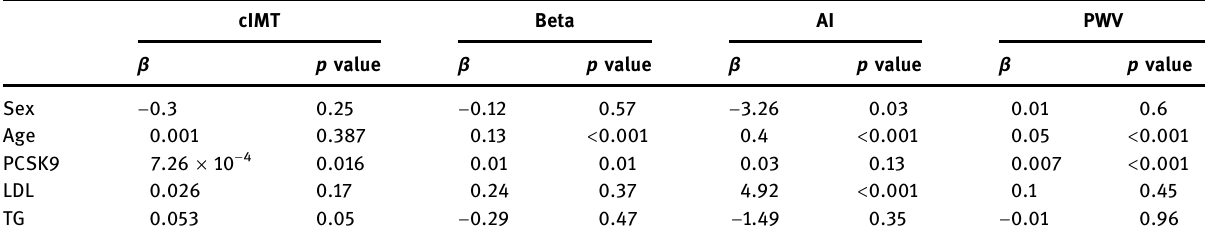
Table 5: Multivariable regression analysis of various parameter e ff ects on vascular changes cIMT Beta AI